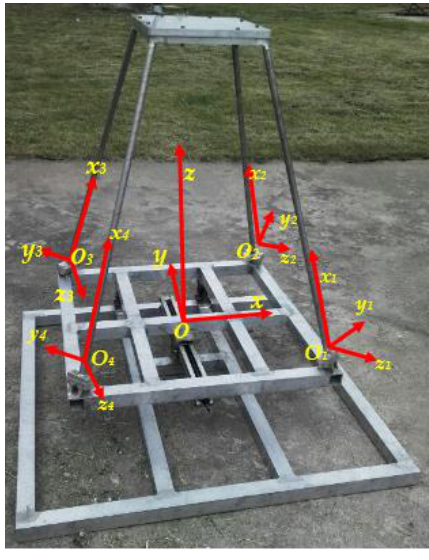
Figure 6. The coordinate system.